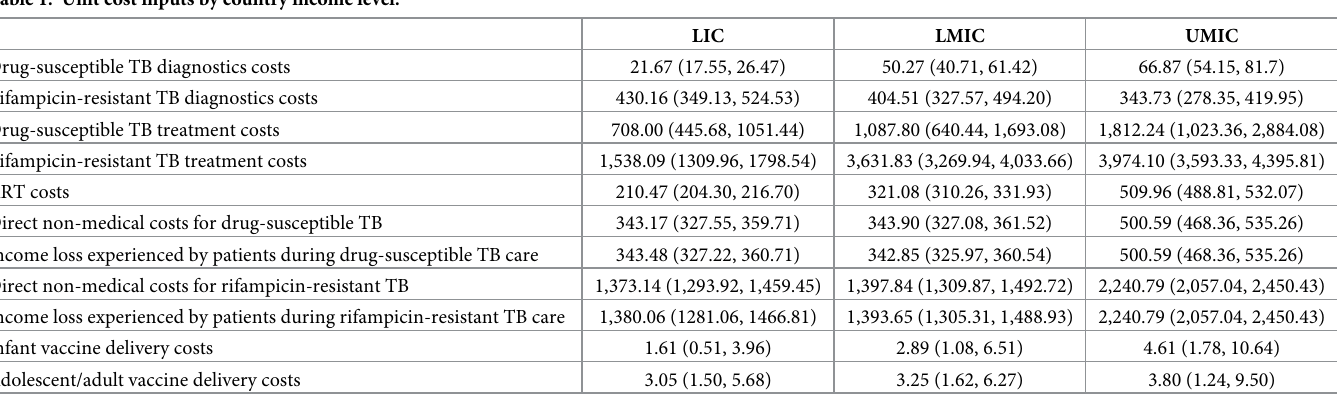
Table 1. Unit cost inputs by country income level.